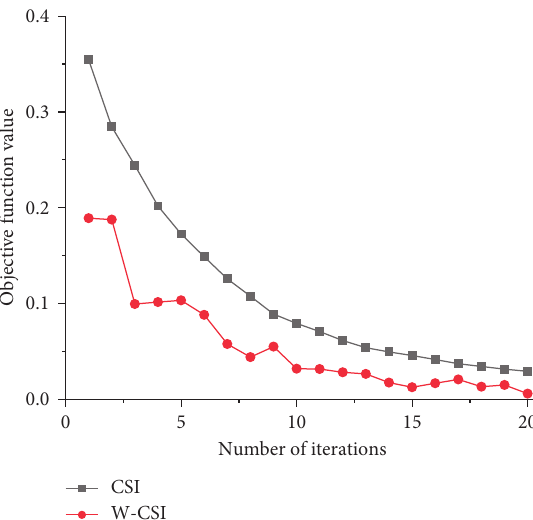
Figure 21: The comparison of convergence curves between CSI and W-CSI.